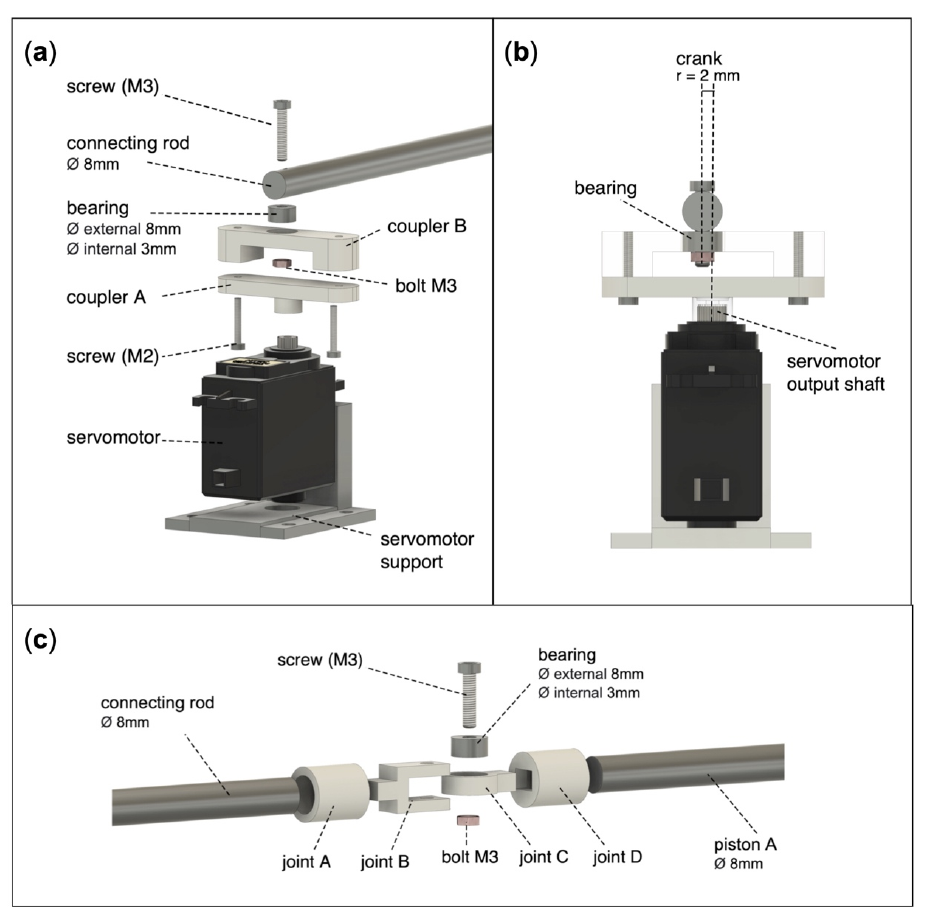
Figure 1. 3D renderings of first part of the electromechanical system: ( a ) exploded view of the coupling between the servomotor output shaft and the ad-hoc designed connecting rod—crank mech- anism; ( b ) perspective to appreciate the 2-mm crank obtained with the 2-level coupler; ( c ) exploded view of the coupling system between the connecting rod and piston A.